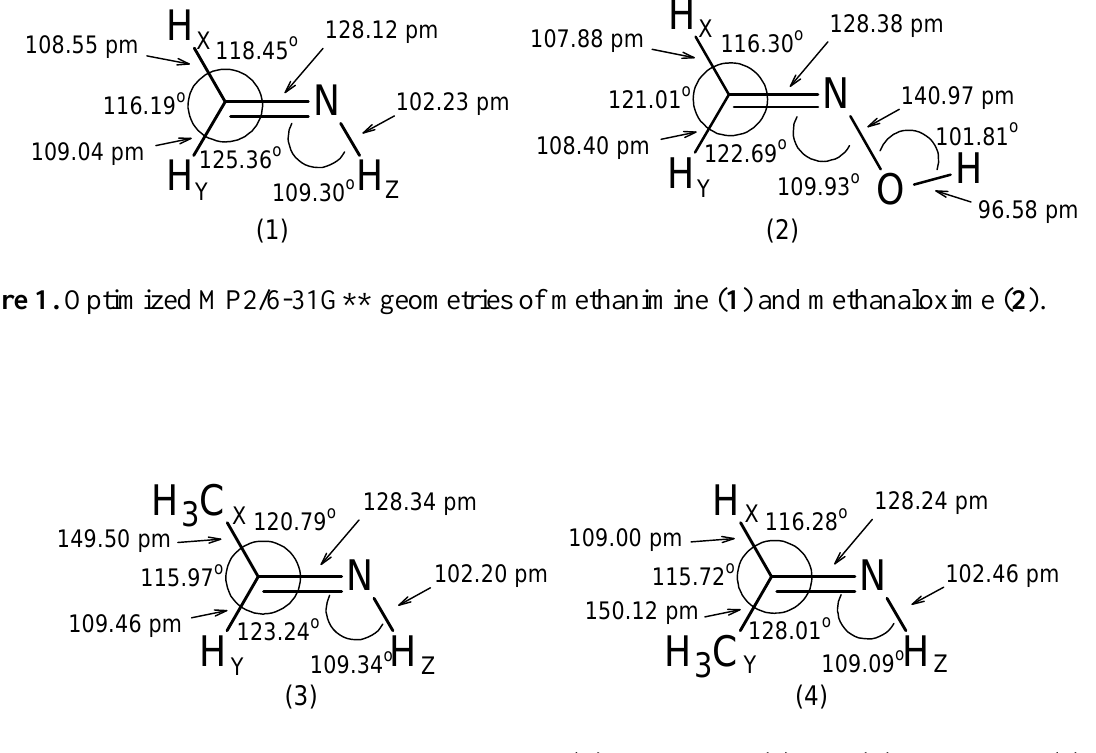
Figure 2. Optimized MP2/6-31G** geometries of (E)-ethanimine ( 3 ) and (Z)-ethanimine ( 4 ). One of the C-H bonds in the H C- group is eclipsed to the C=N 3